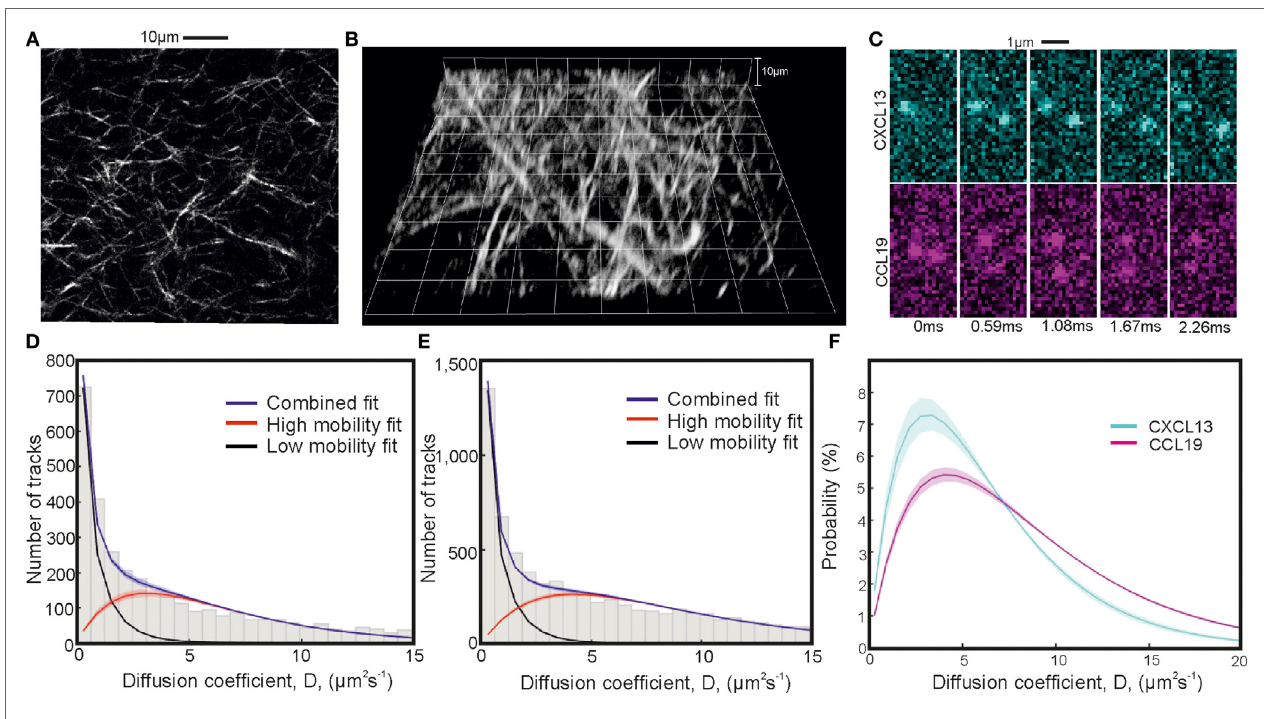
FigUre 5 | Single-particle tracking of chemokines in collagen. Second-harmonic imaging microscopy (SHIM) of collagen network in (a) 2D and (B) 3D. (c) Representative consecutive submillisecond images of chemokines in collagen. (D,e) Fitted diffusion coefficient distribution of CXCL13-AF647 and CCL19-AF647 showing mobile and immobile components in a collagen matrix with (F) just the fitted high-mobility diffusion coefficient distributions of CXCL13-AF647 (cyan) and CCL19-AF647 (magenta) (shaded areas indicate one SD).